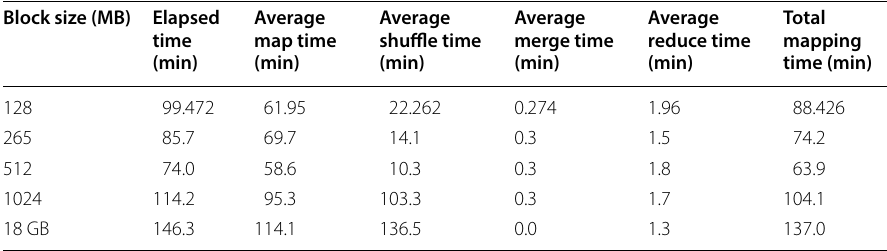
Table 6 Clustering 17.79 GB raster image using a 2 node Hadoop cluster Block size (MB) Elapsed